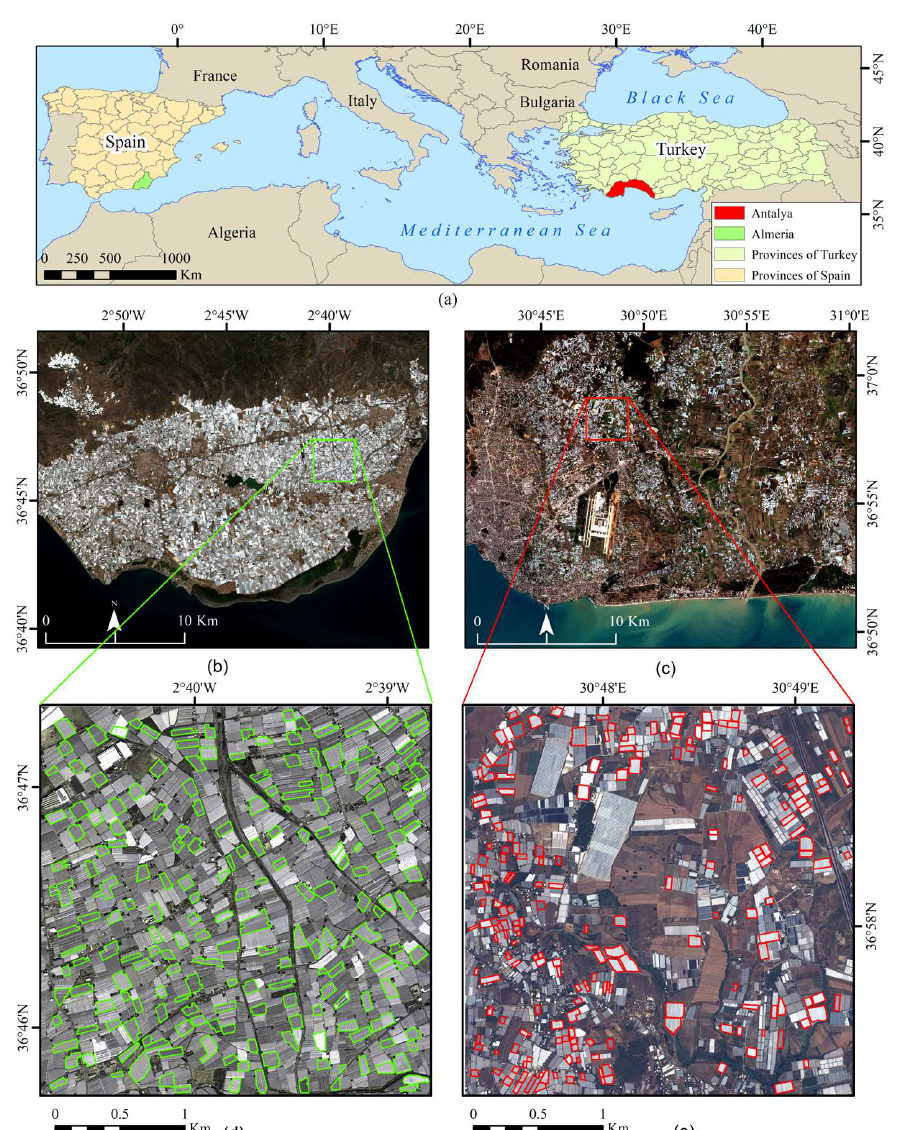
Figure 1. ( a ) Global location of the Almería and Antalya study sites; ( b ) general overview of the PCG in Almería, and ( c ) Antalya; ( d ) study area in Almería and ( e ) Antalya. Note: those polygons de- picted in ( d , e ) are the manually digitized reference polygons used for segmentation quality assess- ment.